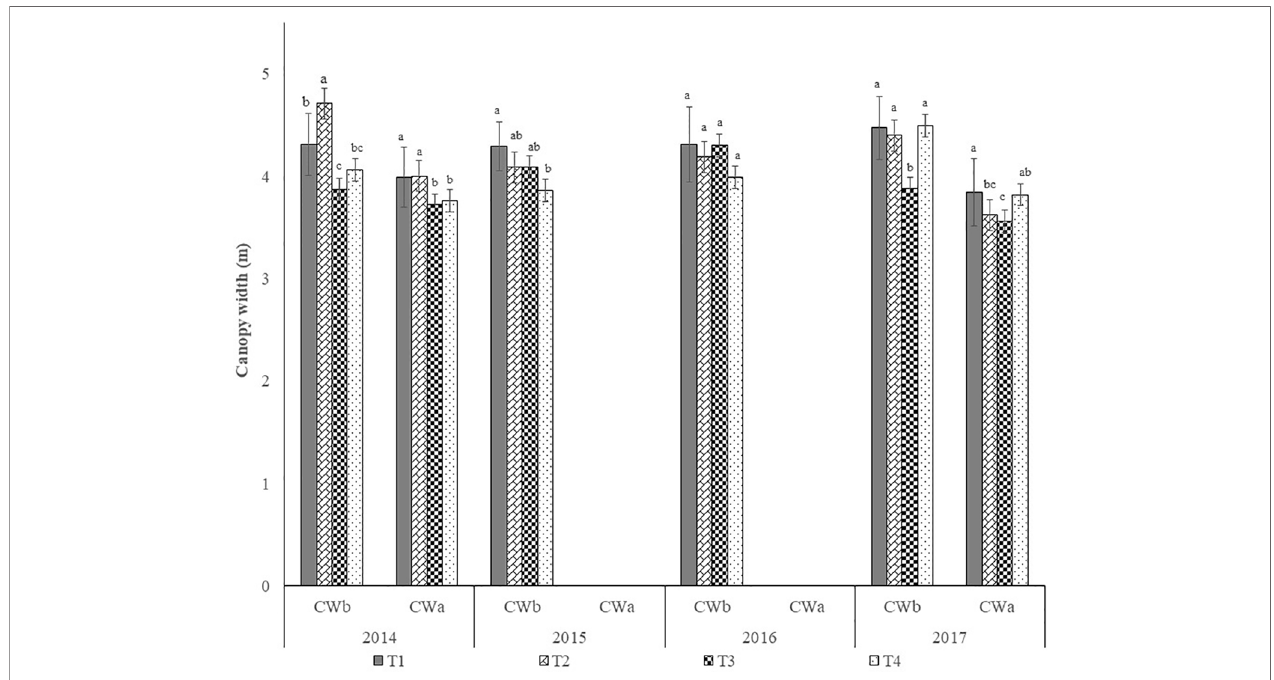
FIGURE 9 | Canopy width before and after pruning in each year (mean±sd). Legend: CWb, canopy width before winter pruning; CWa, canopy width after winter pruning; T1, treatment 1; T2, treatment 2; T3, treatment 3; T4, treatment 4. In each year, before and after pruning, columns followed by the same letter are not signi fi cantly different by Duncan multiple range test at the 5% level, with exception of CWa in 2014 and 2017, where p ≤ 0.1.